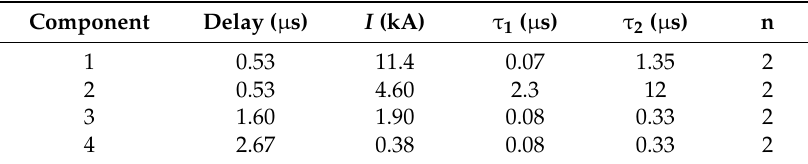
Figure 4 . Current values at the structure base. Solid line: analytical Equation (15); Dots: extracted from [2]. Figure 4. Current values at the structure base. Solid line: analytical Equation (15); Dots: extracted Ground resistivity values ( a ) 100 Ω∙m; ( b ) 1000 Ω∙m. Table 1. Heidler function parameters for 100 Ω∙m ground resistivity. Table 1. Heidler function parameters for 100 Ω · m ground resistivity.